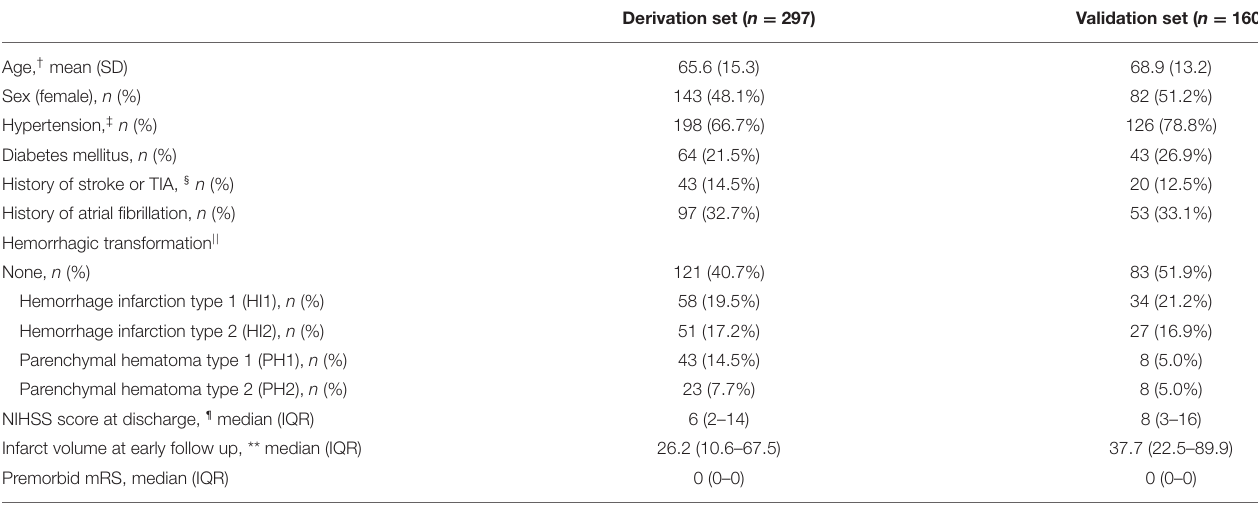
TABLE 1 | Characteristics of patients included in the derivation and validation set.